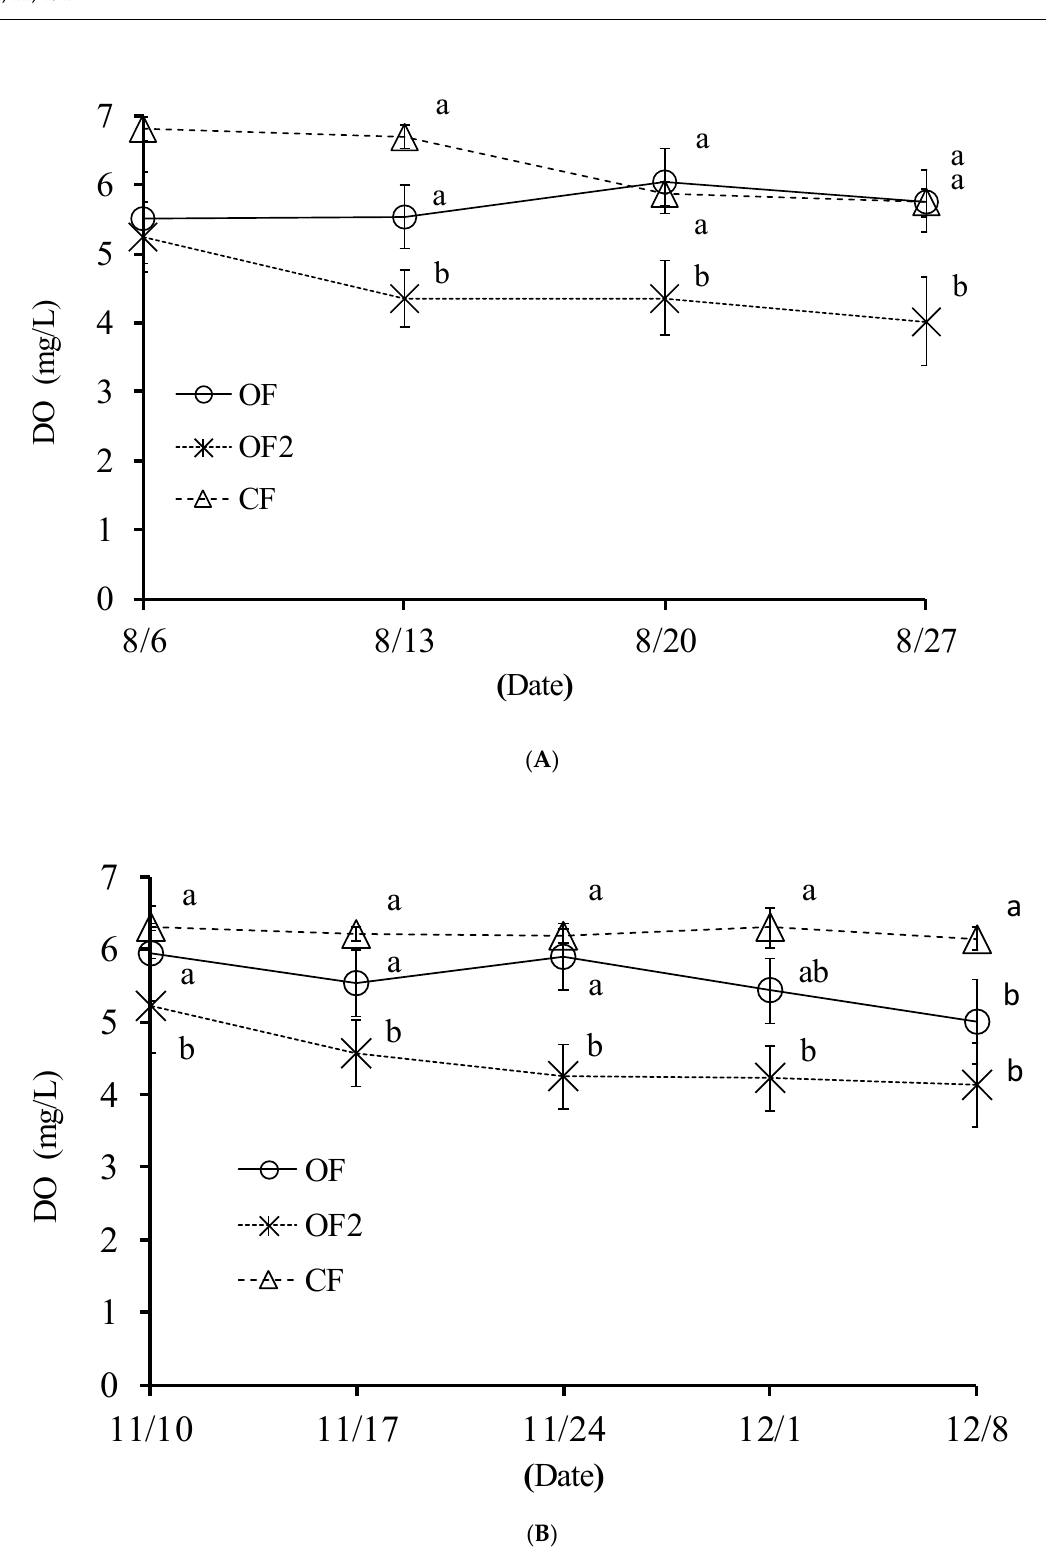
Figure 5. Changes in the dissolved oxygen levels of hydroponic solutions containing different fertilizers. ( A ): Summer, ( B ): Autumn. Measurements continued for 10 days after summer harvest and for 15 days after autumn harvest. Error bars on vertical columns indicate standard error ( n = 3). Identical letters between bars indicate no significant difference ( p < 0.05) among treatments according to Tukey’s multiple range test. OF (organic fertilizer): corn steep liquor (CSL) applied as organic fertilizer at the same amount of total nitrogen as that in the half unit of Otsuka A formula; OF2: CSL applied at twice the amount of total nitrogen in OF; CF (chemical fertilizer): half unit of Otsuka A